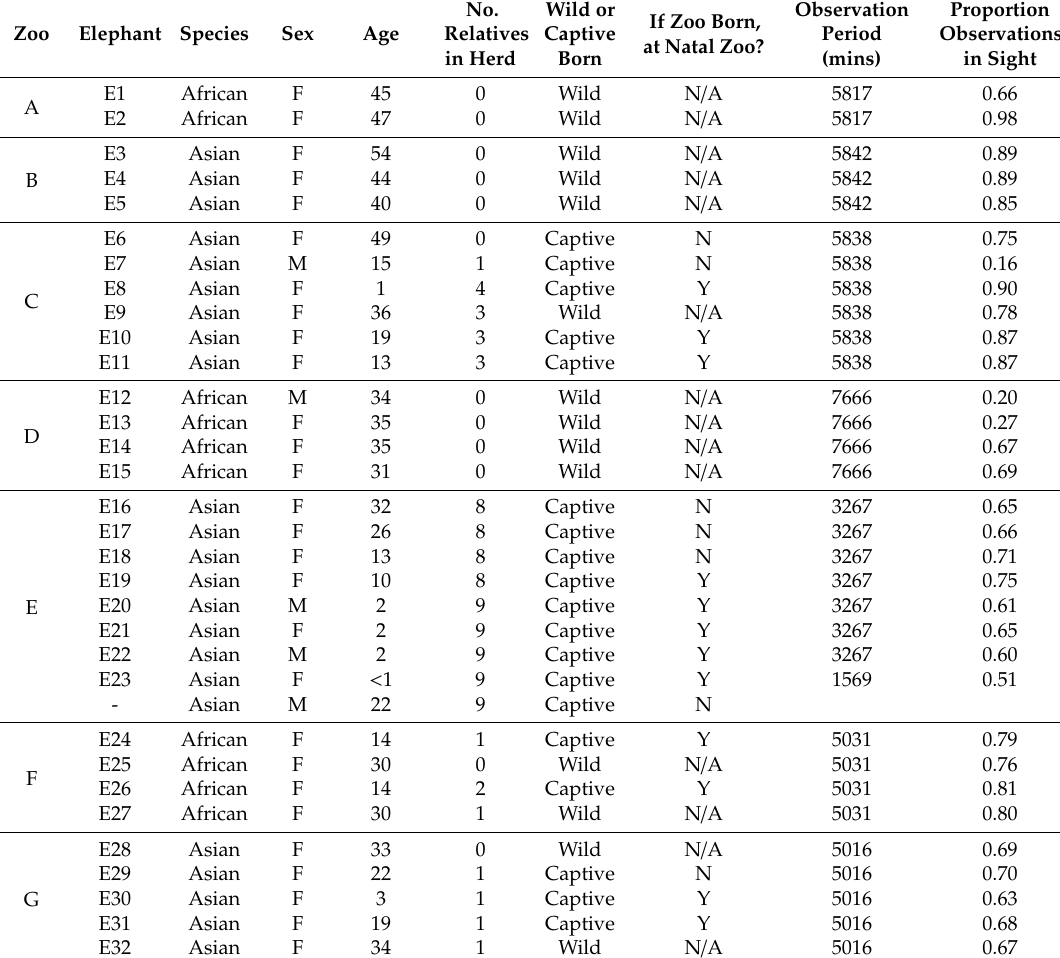
Table 1. Elephant and herd demographics for the study elephants at the onset of the study period (October 2015). Zoo Elephant